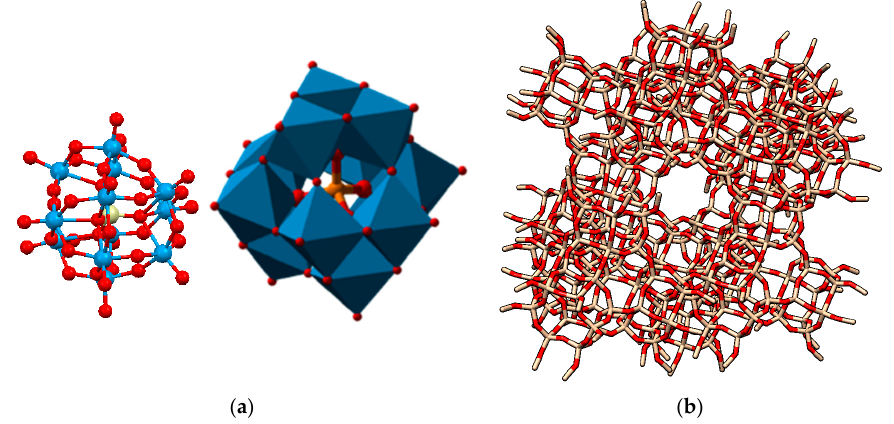
Figure 1. Schematic drawings of ( a ) Keggin heteropolyoxometalate (red: oxygen, blue: tungsten, orange: X atom) and ( b ) supercage of Y zeolite (red: oxygen, yellow: silicon or aluminium). The drawings are not at the same scale.